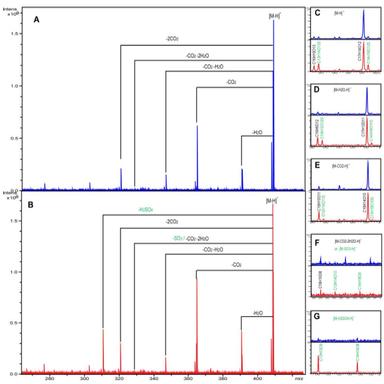
Tandem mass spectra of NOM molecules at nominal m/z 409 obtained with 50% MeOH aqueous solution (A) or 100% MeOH (B) as spray solvent; The scale-expanded mass spectra of the precursor ions (C) and the product ions, (D) −, (E) −, (F) − or −, (G) −.